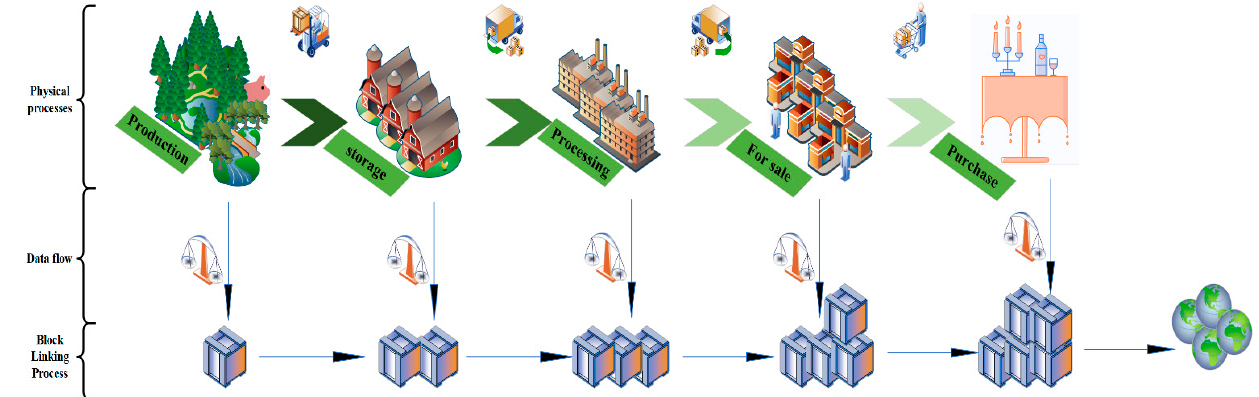
Figure 1. Blockchain traceability of physical state processes and data flow states. Data collection: Most of the data collected on the farm are obtained from sensors, such as temperature sensors showing changes in temperature, light sensors showing